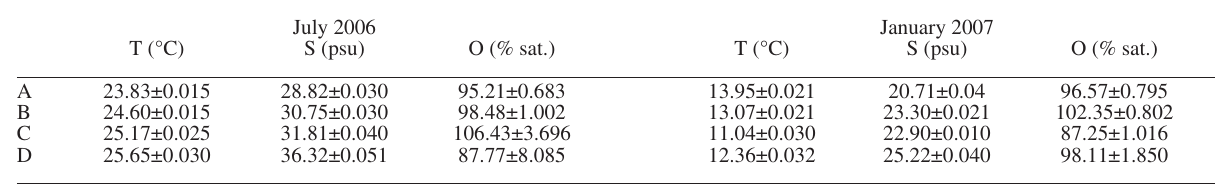
Table 1. – Mean (± S.E.) salinity (S), temperature (T) and oxygen saturation (O) measured at each sampling